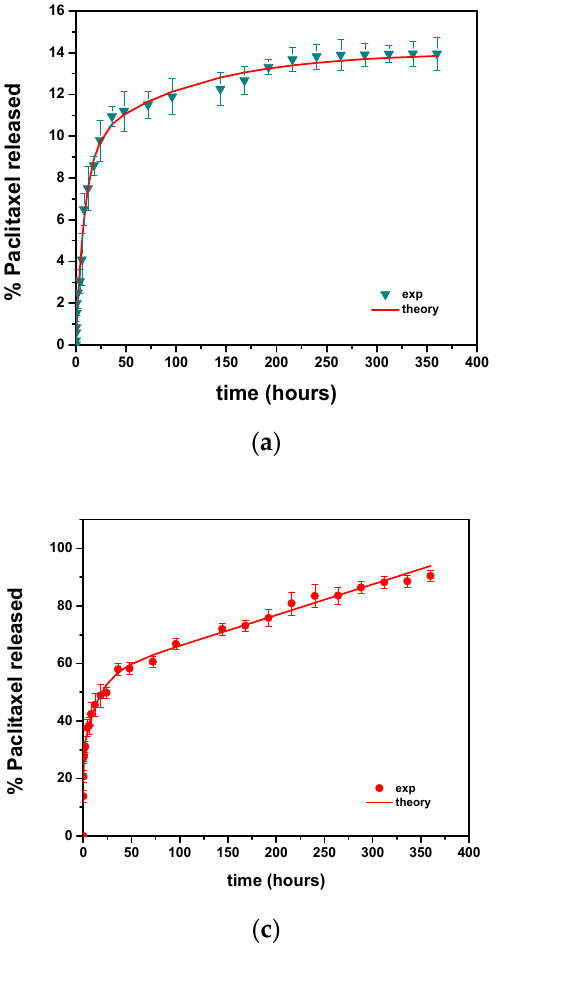
Figure 11. Comparison between experimental release data (symbols) and fitted curves (lines): ( a ) pure drug; ( b ) PCL-GLY; ( c ) PCL-PE; ( d ) PCL-XYL nanoparticles.